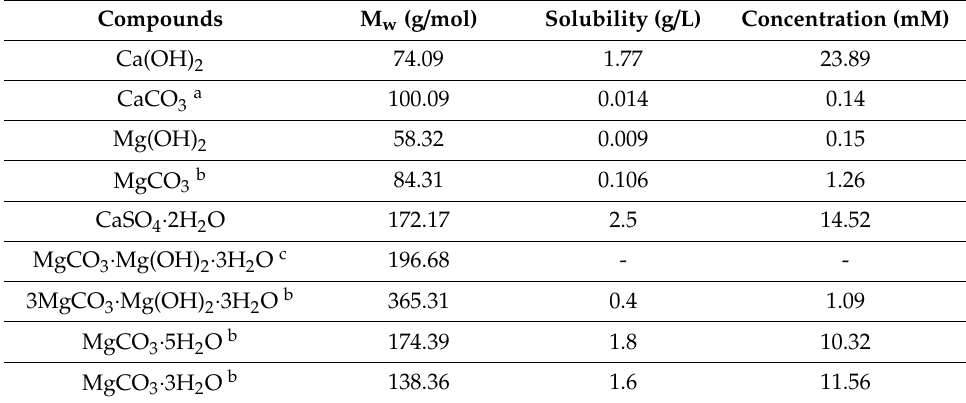
Table 3. Potential compounds that can form by interaction of CaO with sea water.